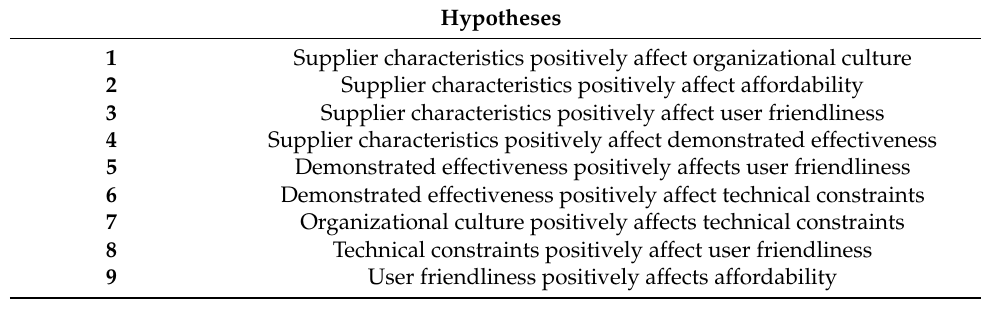
Table 5. Hypotheses on the significant influences between factor groupings.